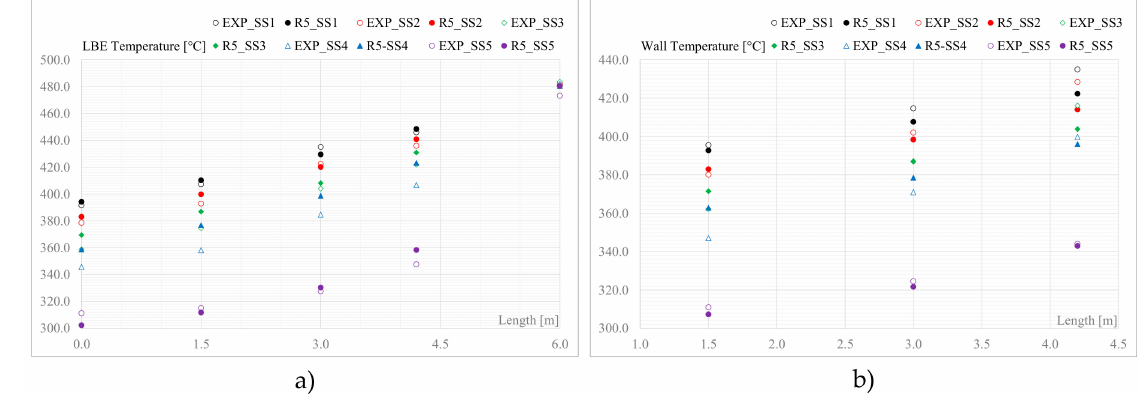
Figure 13. EF-T3, exp. vs. RELAP5-3D: ( a ) SG LBE bulk temperatures; ( b ) wall temperatures.